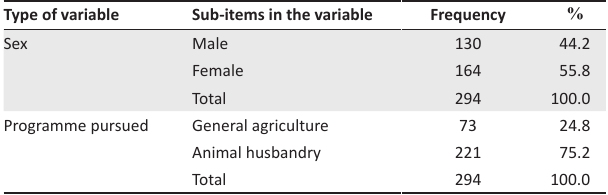
TABLE 2: Socio-demographic characteristics of